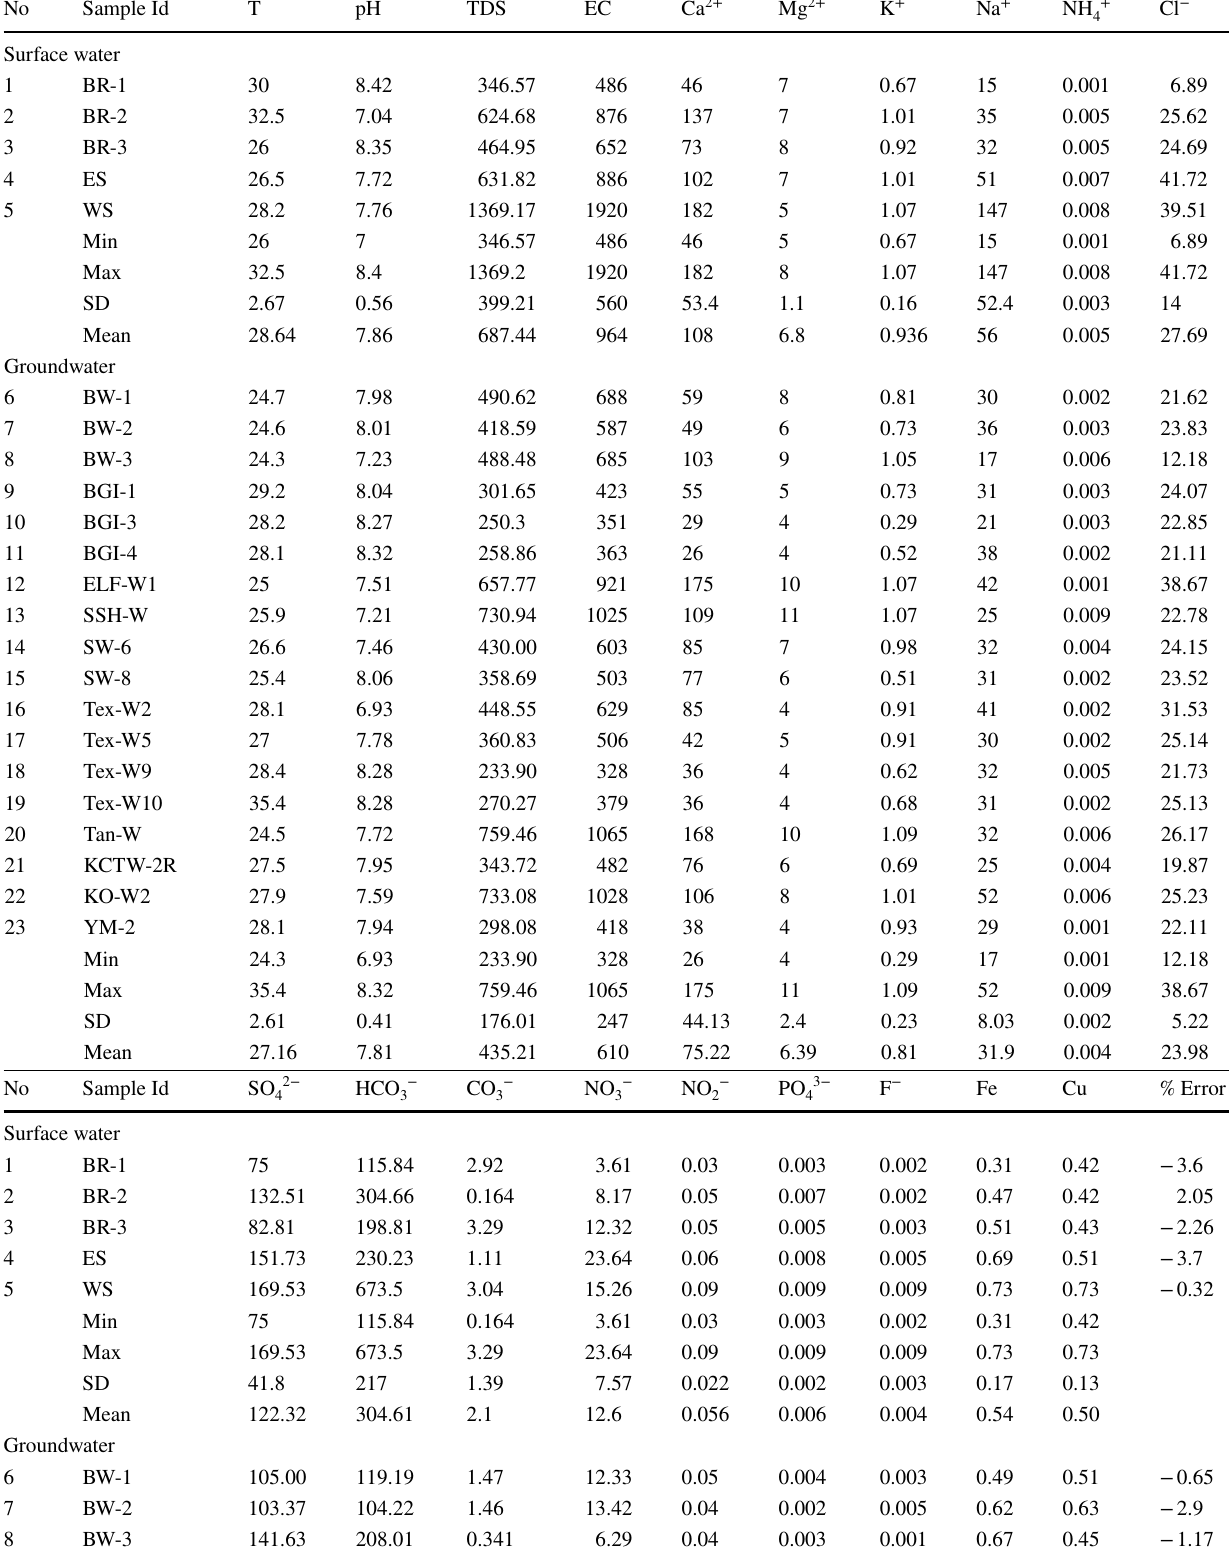
Table 3 Results of chemical analyses of the surface water and groundwater samples of the study area (date of sampling: May 2017); explanation: EC (µS/cm), concentrations (mg/l), temperature (°C) No Sample